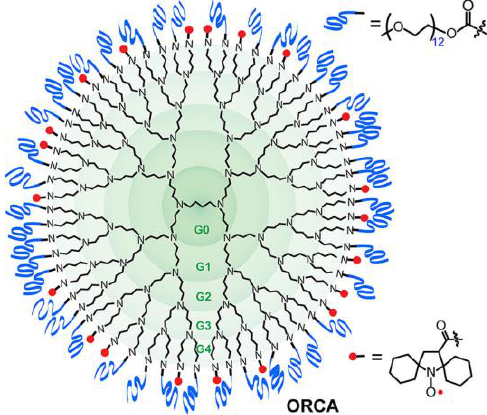
Figure 8. The structure of organic radical contrast agents (ORCA) constructed by sequential con- jugation of spin-label 178 and mPEG-12-NHS to a fourth-generation polypropylenimine (PPI) dendrimer (PPI-G4) with 64 terminal amine groups. Reprinted with the permission of ACS from ref. [82].